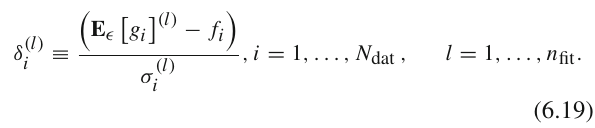
Table 27 The values of the quantile estimator in PDF space, ξ Eq. (6.16), separated into the contributions from individual flavor com- binations together with the corresponding bootstrap uncertainty Flavor ξ